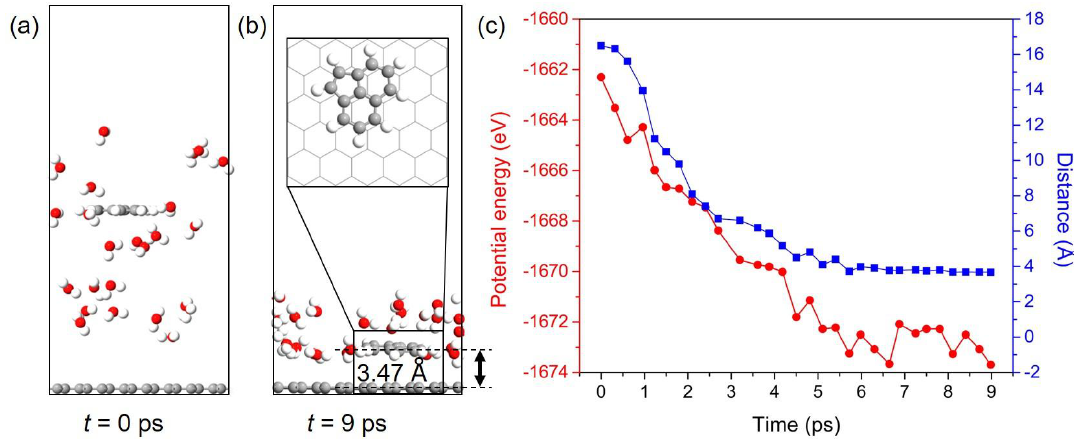
Figure 7. Configuration snapshots of the Ace/Gr adsorption system at ( a ) t = 0 ps and ( b ) t = 9 ps. ( c ) The potential energy (left) and distance (right) of Ace molecule adsorbed onto Gr with simulation time.